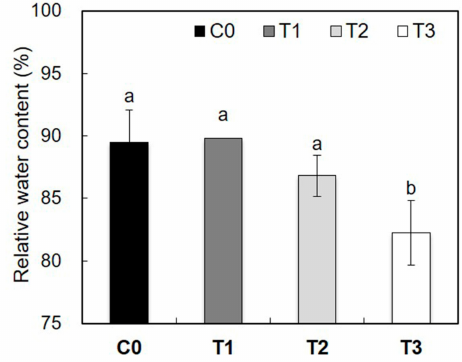
Figure 10. Relative water contents (RWC) in yellow-poplar leaves exposed to the natural day/night cycle (C0, black bar) and the day/night with artificial lighting cycle (T1, T2, and T3 denote dark gray bar, light gray bar, and white bar, respectively). Data indicate mean ± SD ( n = 5). Different lowercase letters on the bars indicate significant differences among treatments (Tukey’s test after one-way